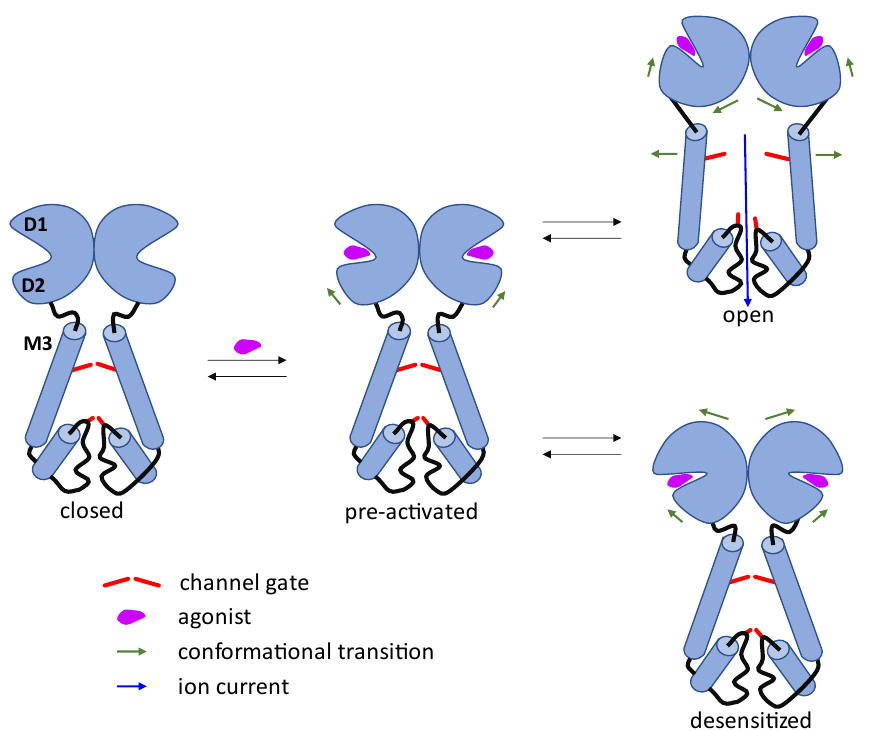
Figure 2. Simplified scheme of the AMPA receptor mechanism of operation (the ion channel opening and closing).